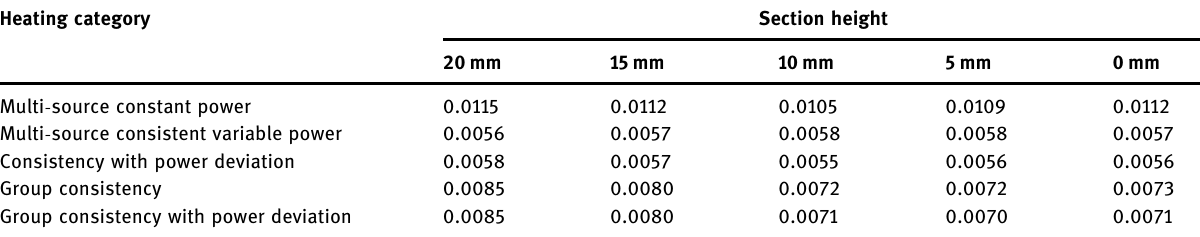
Table 3: Horizontal section COV